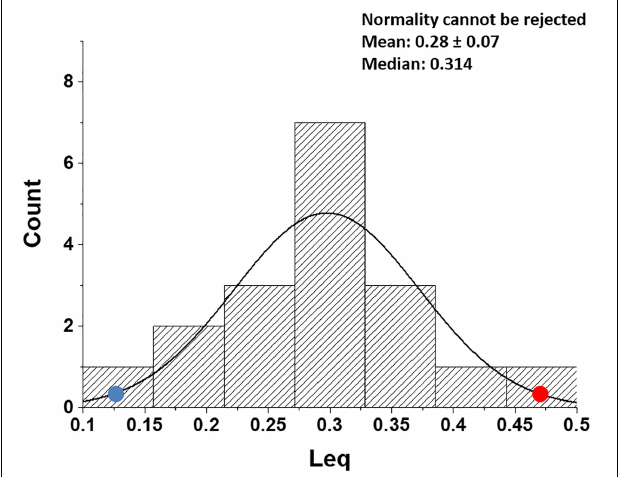
FIGURE 7 | Correlation between Leq and a cardiac output ( ˙ Q ) in the condition indicated. Red and blue dots refer to the two subjects shown in Figures 5A,B , respectively (from Beretta et al., 2019).